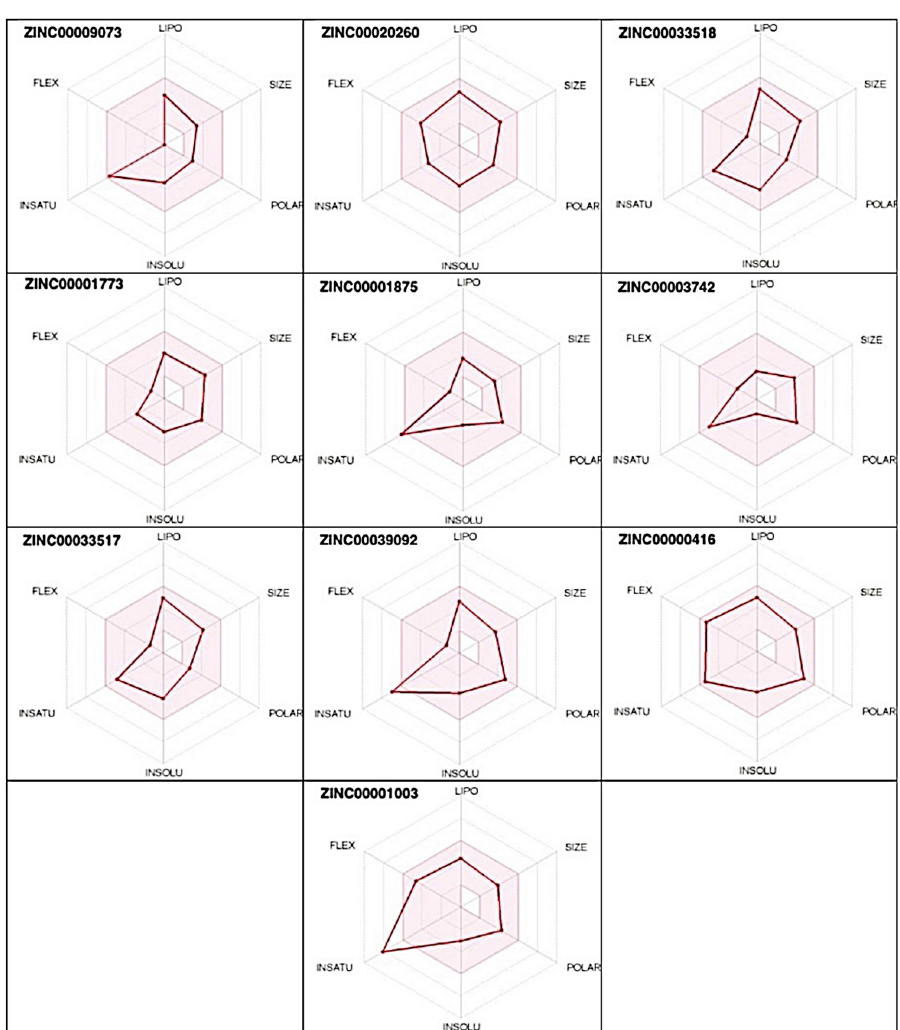
Fig 4. Radar charts of the 10 candidate molecules. The bioavailability radars of the top 10 shortlisted compounds are shown in Fig 4. From the radar plot, it can be seen that ZINC00009073 (Apomorphine), ZINC00020260 (Oxyphencycli- mine), ZINC00033518 ((S)-canadine), ZINC00001773 (Naltrexone), ZINC00003742 (Norflox- acin), ZINC00033517 ((R)-canadine) and ZINC000000416 (Labetalol) are likely to be orally bioavailable molecules as their physicochemical properties (red line radar) lie within the opti- mal zone (pink region). However, ZINC00001875 (Oxolinic acid), ZINC00039092 (Hespere- tin) and ZINC00001003 (Benorilate) show low saturation (fraction of carbon sp 3 (Fsp 3 ) hybridization) values, i.e., 0.23, 0.19 and 0.12, respectively (S3 Table), making them not good for oral bioavailability. Additionally, from the Brain Or IntestinaL EstimateD permeation (BOI- LED-Egg) analysis (S1 Fig), the blue dots in egg white and egg yolk show Apomorphine, (S)- canadine, Naltrexone, Norfloxacin, Hesperetin, Labetalol and (R)-canadine as P-glycoprotein (P-gp) substrates while the red dots show that Oxolinic acid, Oxyphencyclimine and Benori- late have structural barriers that do not allow them to bind to P-gp causing problems in drug excretion triggering other toxicity outcomes [39].